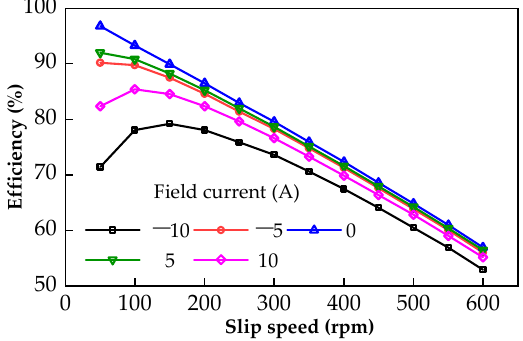
Figure 13. The efficiencies of the coupling under different field currents.